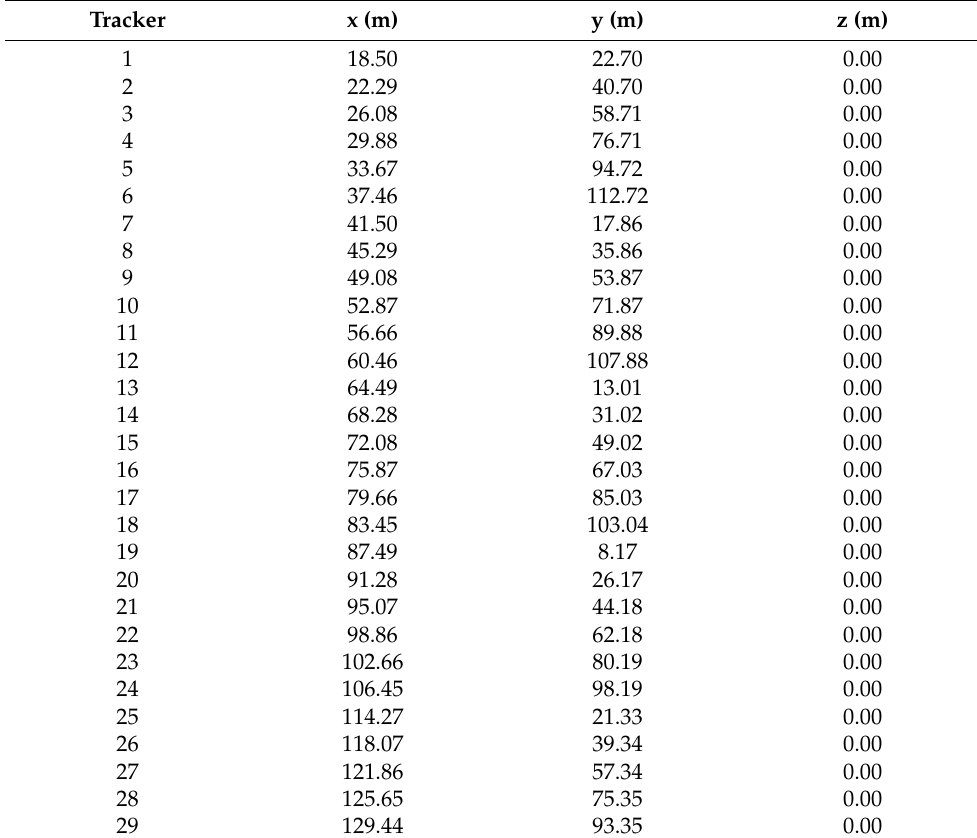
Figure 5. Dual-axis trackers plant Peñarroya I. Table 1. Coordinates (m) considered for each